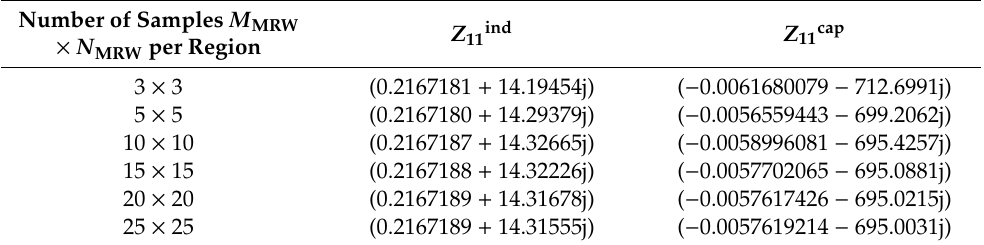
Table 1. Convergence pattern with respect to the number of MRW samples per region of the inductive, Z 11ind , and capacitive, Z 11 cap , contributions of the MoM coe ffi cient matrix.